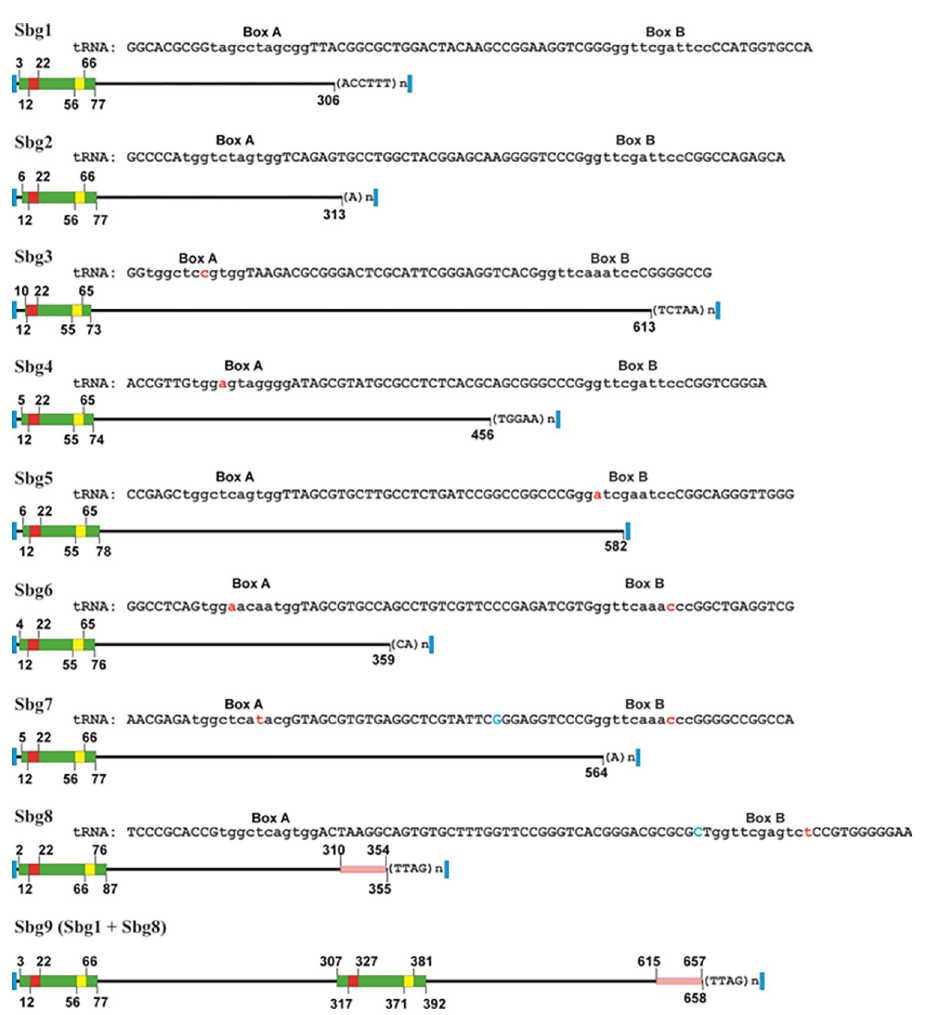
Fig 1. Schemes of the structural organization of the consensus sequences of SINEs of Blattella germanica (Sbg1-Sbg9). Areas corresponding to the following nucleotide sequences are highlighted with a colored background: tRNA-green; “A” box- red; “B” box- yellow; the region similar to the nonLTR retrotransposon-pink; target site duplication- blue. Repetitive microsatellite motifs are indicated in parentheses. “A” and “B” boxes are shown in lower case within the tRNA nucleotide sequences. Nucleotides other than canonical nucleotides are highlighted in red and blue (explanation in the text). The numbers indicate the positions of the nucleotides.